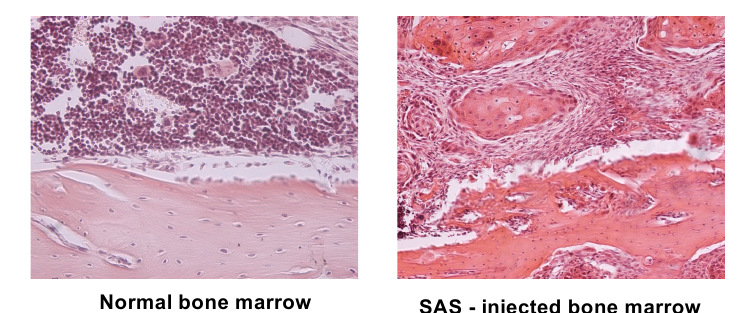
Figure 3. Neurite outgrowth from rat primary dorsal root ganglia (DRG) cells co-cultured with each group of SAS cells. ( A ) Neurite outgrowth from primary neuron cells in co-culture with control medium ( a ), parental SAS ( b ), sh-control ( c ), and sh-MCT4 ( d ) SAS cells for five days, labeled with calcein acetoxymethyl (AM). Scale Bar=50 μ m. ( B ) Quantitative data of ( A) . Error bars: mean ± SD; * = p < 0.05 vs. control; # = p < 0.05 vs. sh-MCT4.